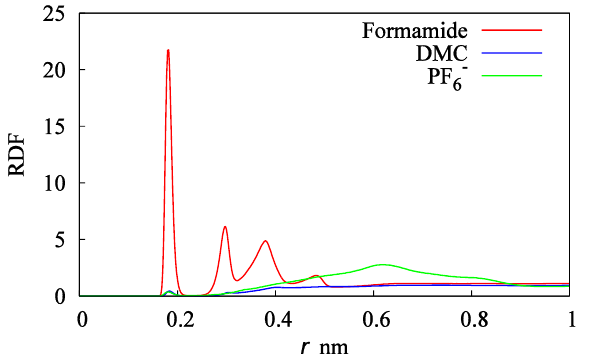
Figure 14. RDF around Li + in the model of 3F + 7DMC + 1M-LiPF 6 (which is the model named 3F + 7DMC).